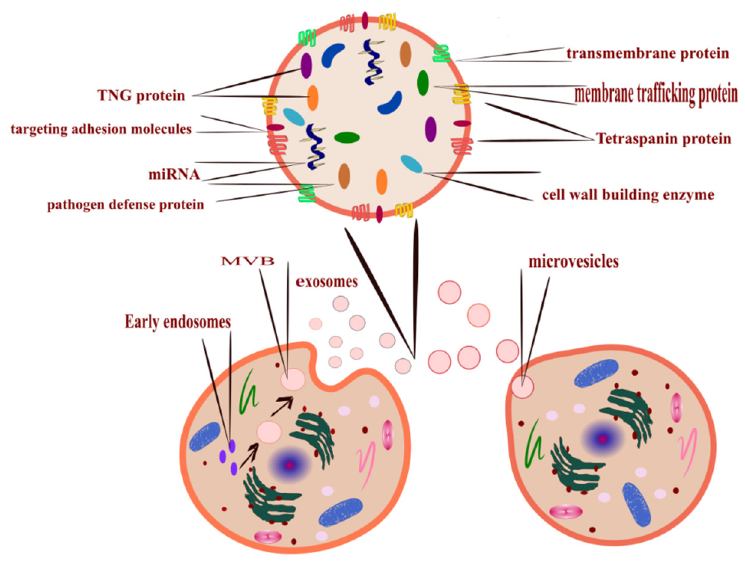
Figure 1. All cells release EVs, the mechanism of EVs formation determines its type, microvesicles released after budding of the plasma membrane ( right-bottom corner), and exosomes ( left-bottom corner) released from MVBs that formed inside the cell from early endosomes. Its cargo is loaded upon maturation ( top corner illustrates EVs cargo). EVs can also be classified according to size; exosomes are the smallest, and apoptotic bodies are the largest.